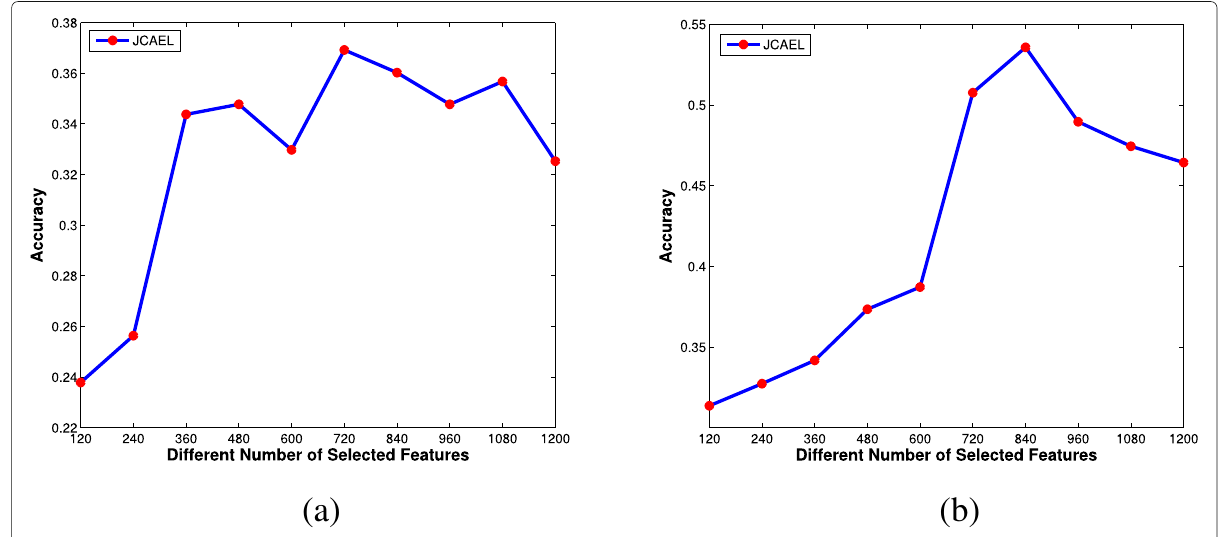
Fig. 5 The performance variation w.r.t the number of selected features using our feature selection algorithm. a HMDB13 ← EID. b UCF10 ← AID